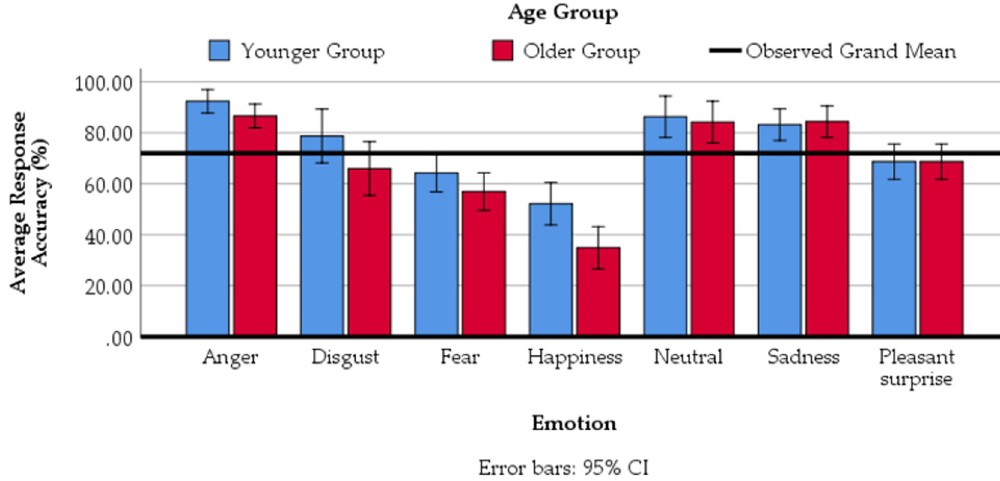
Fig 1. Average accuracy rates (i.e. the number of correctly perceived emotional prosody instances, expressed as a percentage) by age-group.